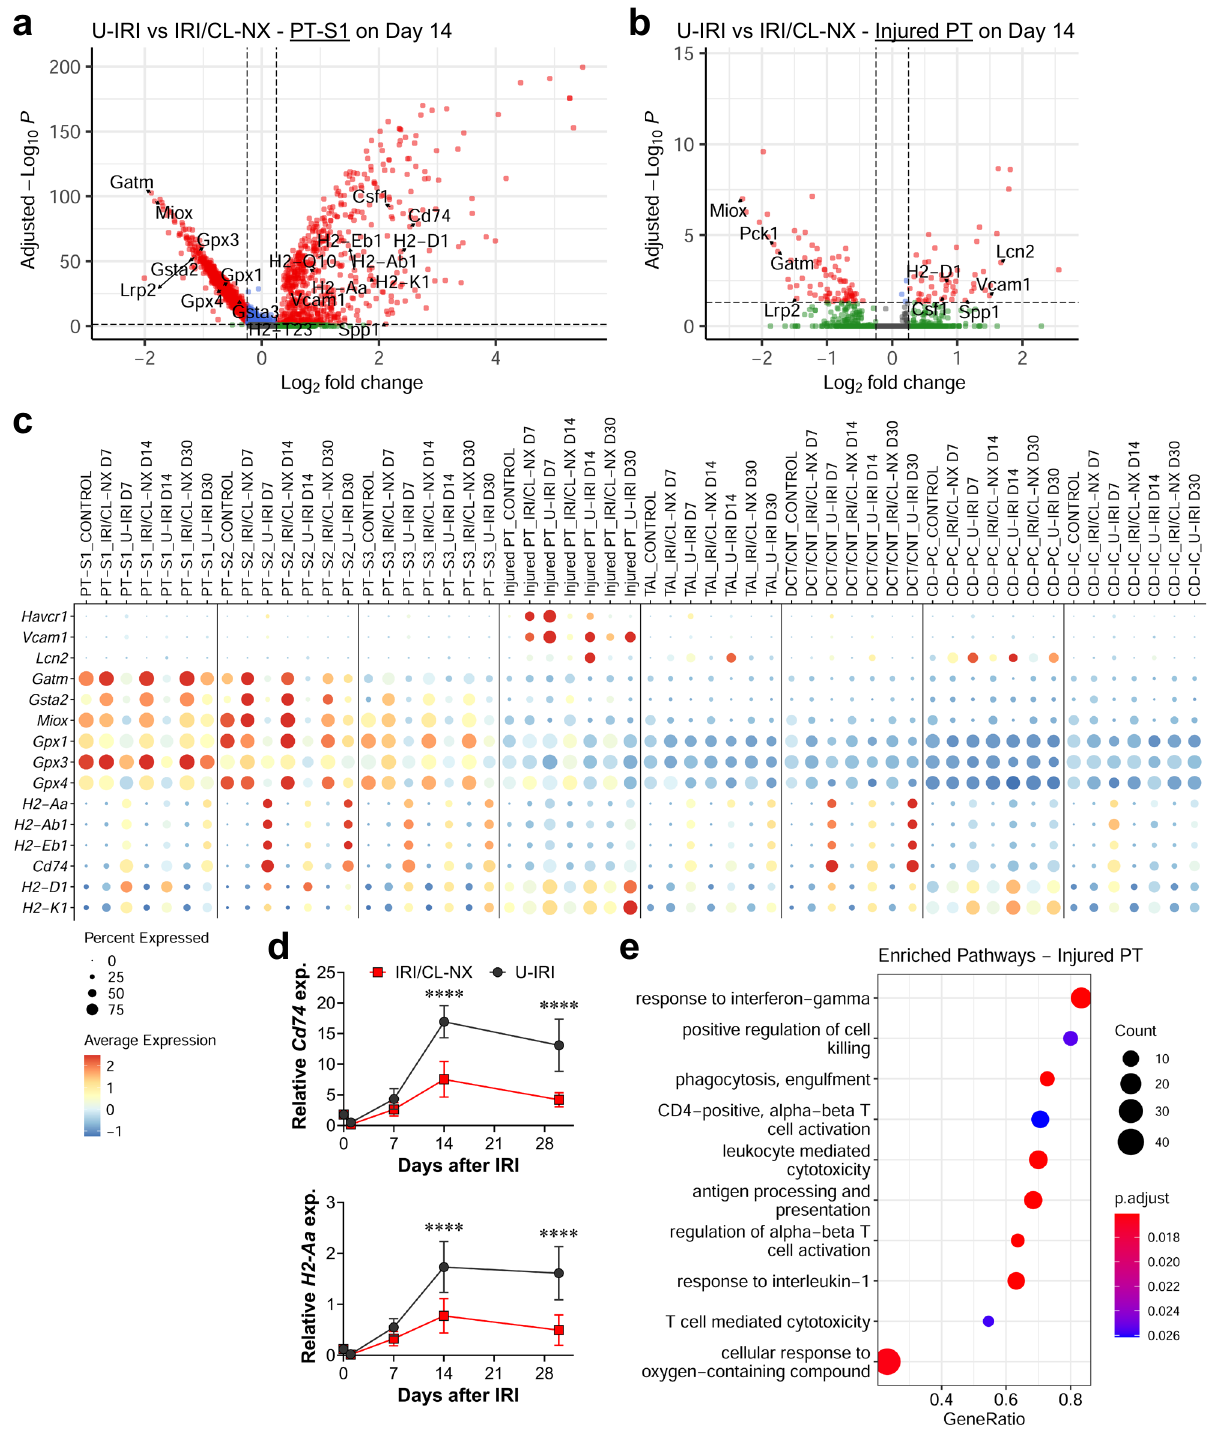
Fig.8|Identifyingtheinjurysignatureofin fl ammation-inducedtubularstress. Wild-type mice were subjected to 27min of ischemia/reperfusion injury (IRI) with contralateralnephrectomy(IRI/CL-NX)orunilateralIRI(U-IRI)andsacri fi cedonday 7, 14, and 30 after injury. Injured kidneys and normal control kidneys were har- vestedforsingle-cell-RNA-sequencinganalysisasshowninFig.3. a , b Volcanoplots demonstrating the differential gene expression in cells from segment 1 of the proximaltubule(PT-S1, a )andinjuredPT( b )14daysafterU-IRIcomparedtoIRI/CL- NX. c Thedistributionandrelativeexpressionoftheinjurymarkers( Havcr1 , Vcam1 , and Lcn2 ), anti-oxidative stress and detoxi fi cation genes ( Gatm , Gsta2 , Miox , Gpx1 , Gpx3 , and Gpx4 ),andthe majorhistocompatibilitycomplexclassII( H2-Aa , H2-Ab1 ,